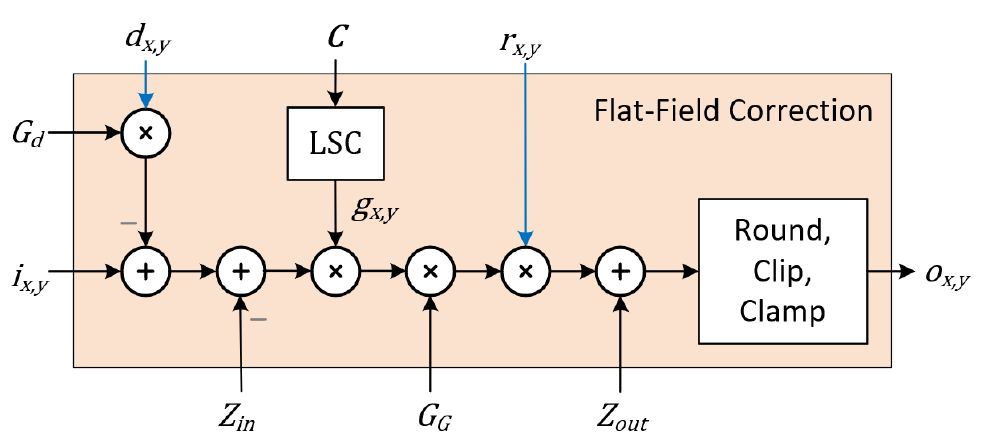
Figure 7. Flat-field correction module block